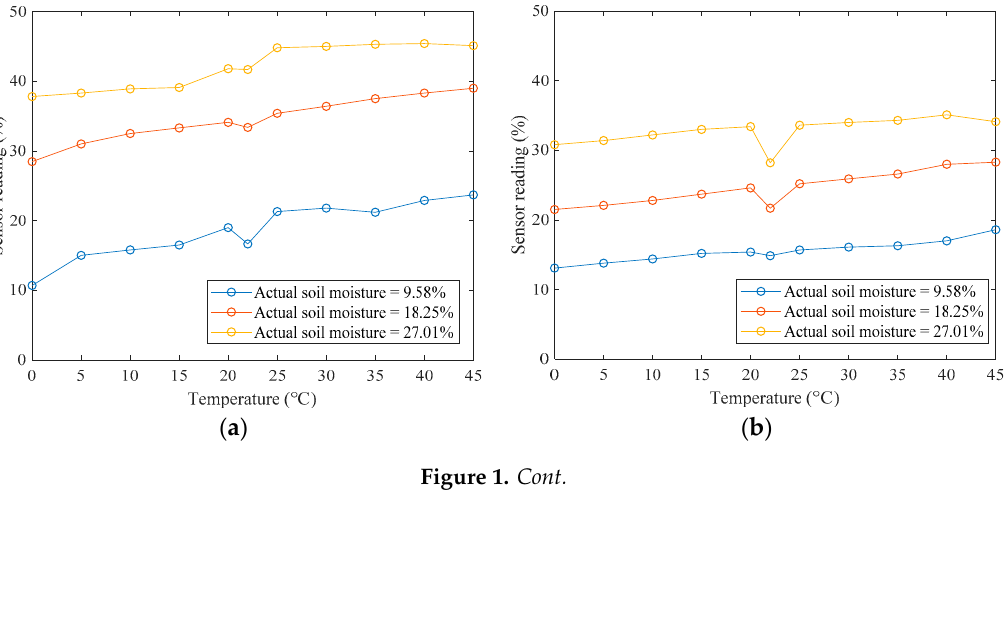
Table 3. Examples of sensor readings under various